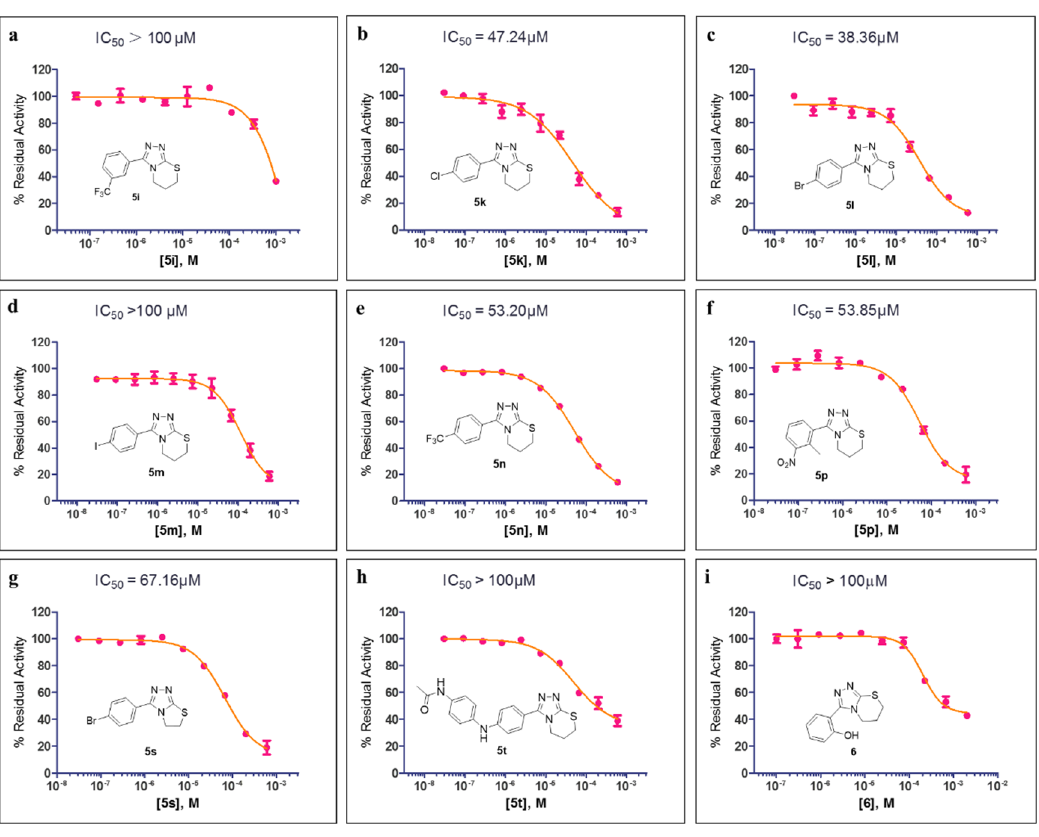
Figure 3. The half-maximal inhibitory concentration (IC 50 ) curves of 5i ( a ), 5k ( b ), 5l ( c ), 5m ( d ), 5n ( e ), 5p ( f ), 5s ( g ), 5t ( h ), and 6 ( i ) against VIM-2.